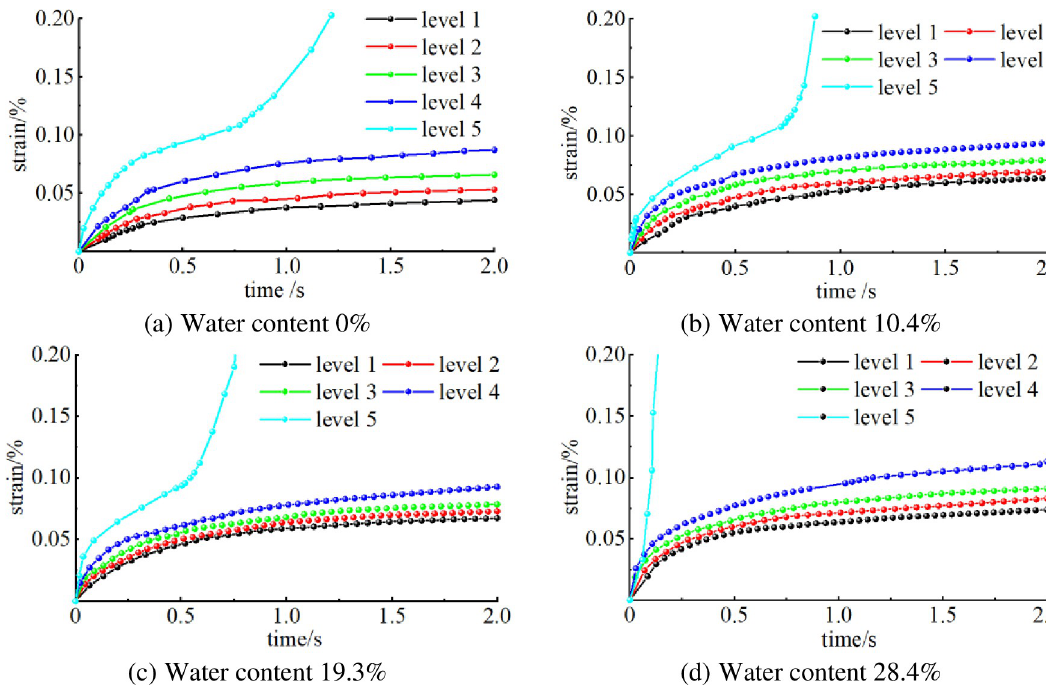
Fig 6. Creep curves of specimens with pores at different water contents. (a) Water content 0%, (b) Water content 10.4%, (c) Water content 19.3%, (d) Water content 28.4%.